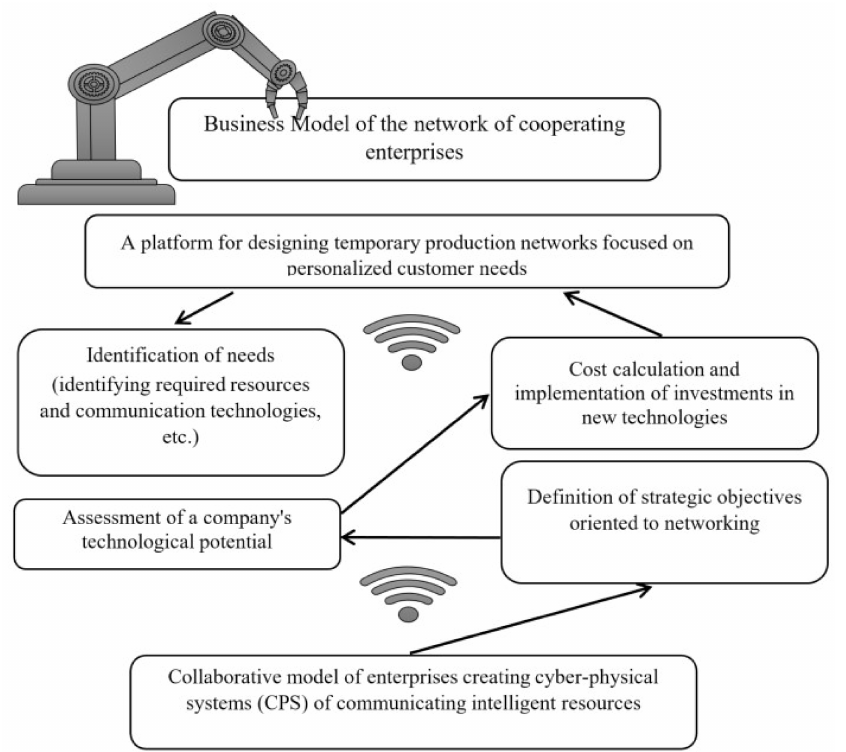
Figure 6. The key steps for companies to adapt to networking. Source: own